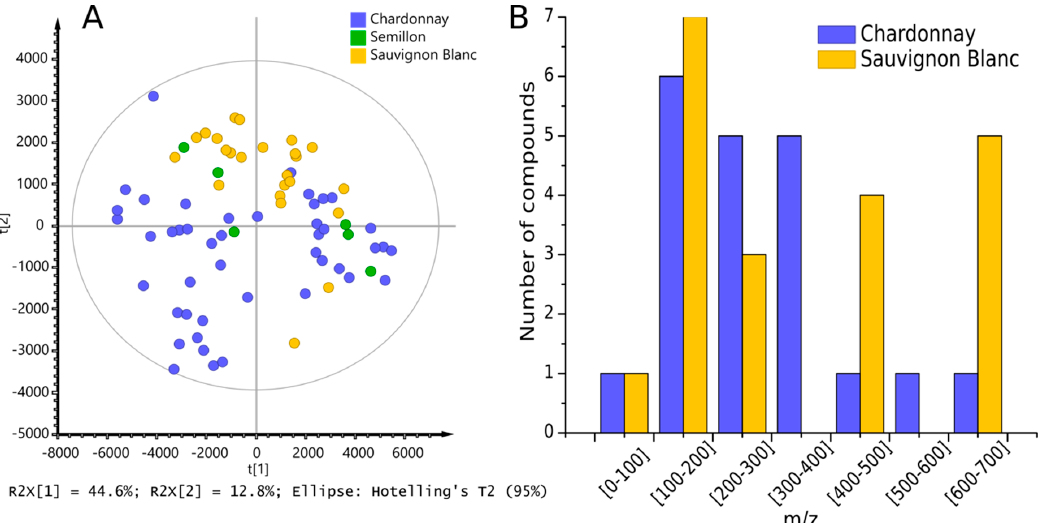
Figure 6. ( A ) Principal component analysis using the 141 nucleophilic compounds previously